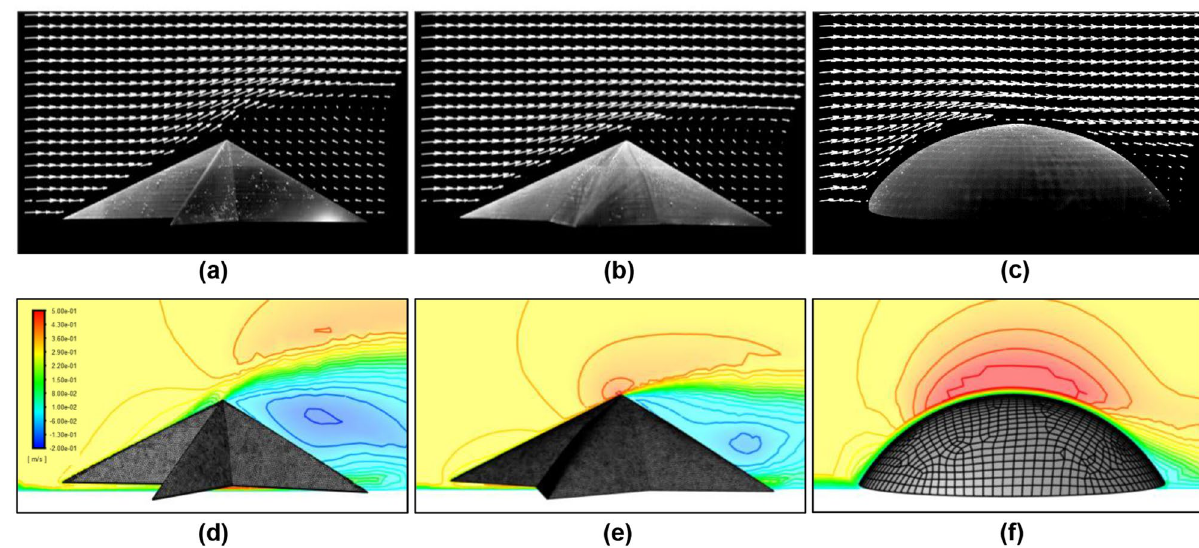
Figure 3. Mean flow visualization from experiments ( a – c ) and CFD simulations ( d – f ) for: AR = 4.0 sea star model ( a , c ); AR = 1.5 sea star model ( b , e ); and spherical dome ( c , f ). The experiments show results for U = 0.47 ± 0.01 ms − 1 while the simulations were performed for U = 0.35 ms − 1 . Panels ( a – c ) show the vector field estimated from PIV while panels ( d – f ) show contours of the mean velocity in the streamwise direction. All panels show the flow field at the central (or median) plane of the models. The sea star models are oriented at (cid:31) = 0 ◦ . Figure created using Ansys Fluent 2019 R2 https ://www.ansys .com/.